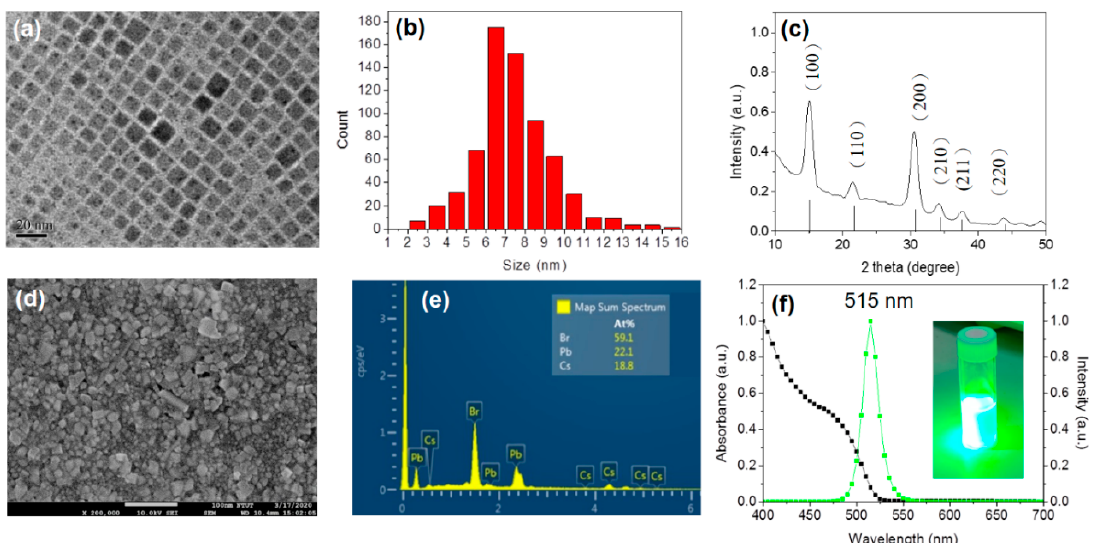
Figure 1. ( a ) TEM image and ( b ) size distribution of perovskite CsPbBr 3 quantum dots (QDs). ( c ) XRD, ( d ) SEM image, ( e ) EDS specta, and ( f ) absorbance and PL spectra of CsPbBr 3 QDs spun on glass substrates. The inset shows the color of CsPbBr 3 QDs.